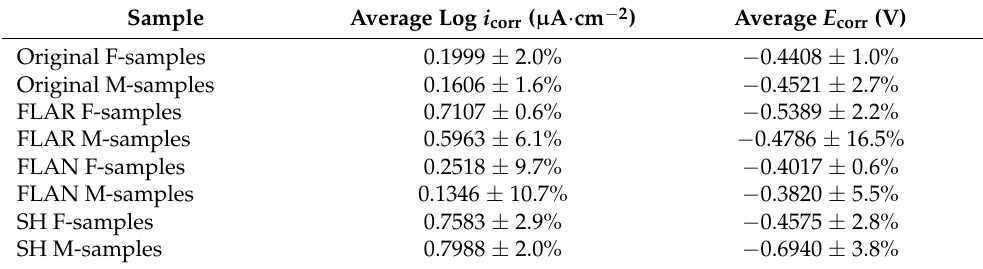
Table 4. Quantitative information about the potentiodynamic polarization curves of 8 samples in 0.5 mol/L NaCl